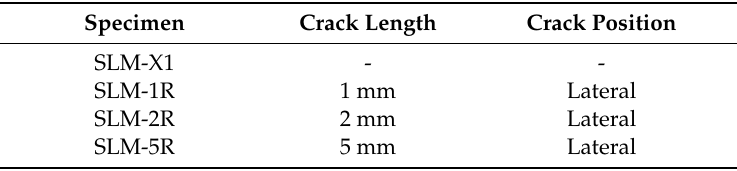
Figure 23. SLM samples: ( a ) Reference sample SLM-X1; ( b ) Sample SLM-1R; ( c ) Sample SLM-2R; ( d ) Sample SLM-5R.